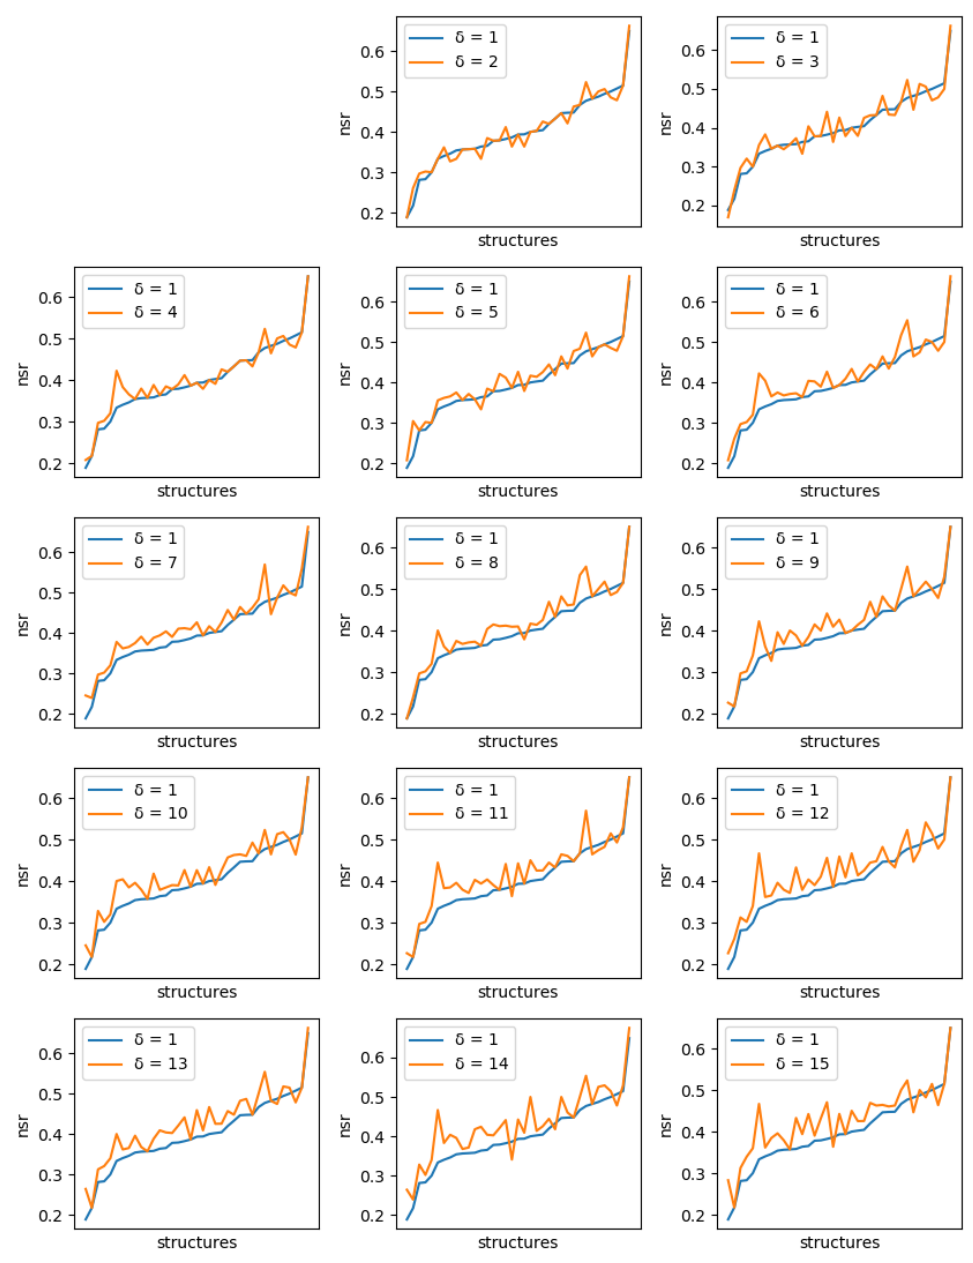
Figure 10. Comparison of the best NSR value obtained with ten 1-diverse sequences ( δ = 1, blue curve) with the best NSR value obtained with libraries of ten sequences of increased diversity all predicted with an allowed gap top optimal energy of 3 kcal/mol. Each plot corresponds to a specific additional value of δ ( δ = 2 to 15, golden curve). Plots are lexicographically ordered from top-left to bottom-right, with increasing values of diversity ( δ ). In each plot, the X-axis ranges over all tested backbones, sorted in increasing order of NSR value for the 1-diverse case and the Y-axis gives the corresponding NSR value. As the diversity requirement δ increases, the NSR value indicated by the golden curve increases also